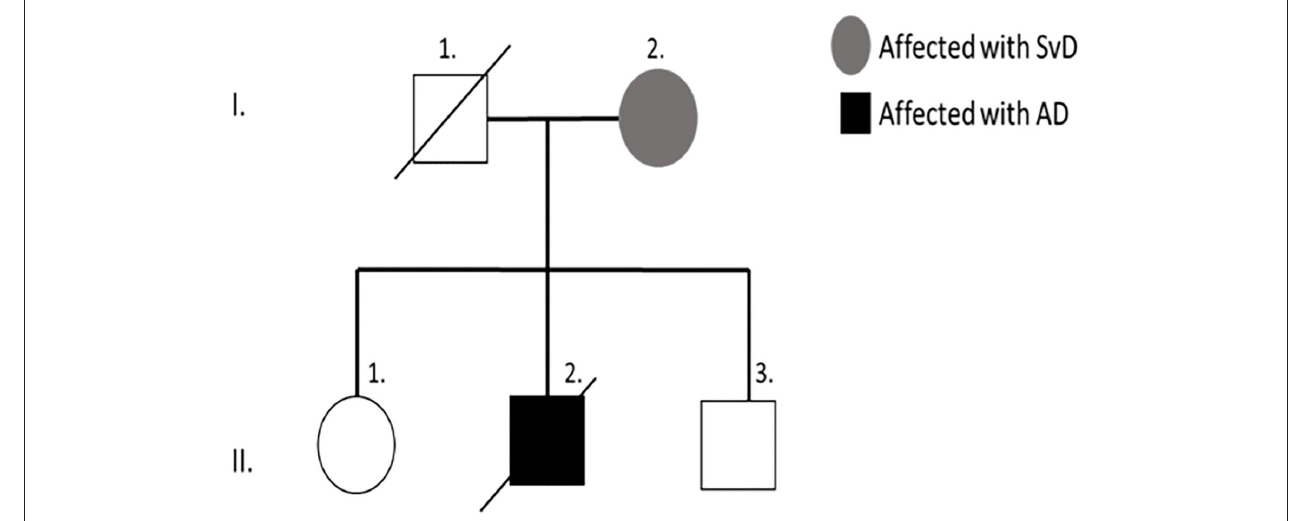
FIGURE 2 | Family tree of proband patient